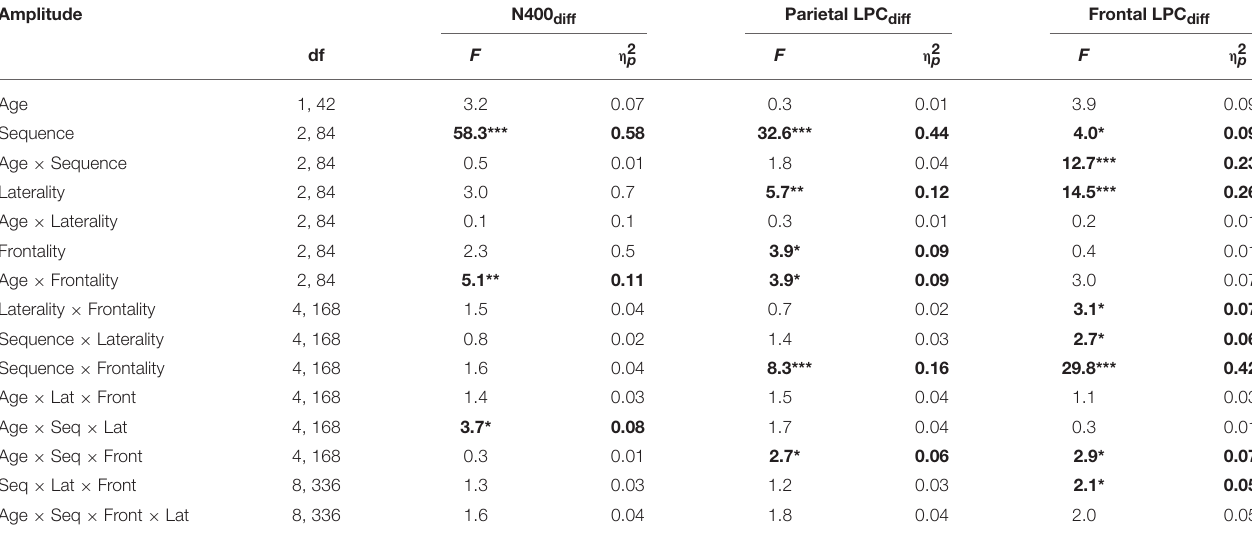
TABLE 2 | Main effects ( F -values and η 2 p ) of Age and Sequence as well as Age × Sequence interactions on amplitudes (additional factors Frontality and Laterality) of the difference ERP (Post minus